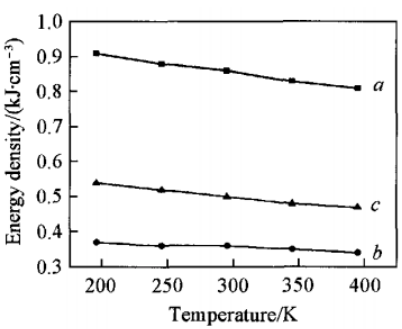
Figure 2. CED (a), vdw (b) andelectrostatic (c) energies of CL-20/TNT cocrystal vs. temperatures [11], with permission from Chemical Journal of Chinese Universities, 2016.